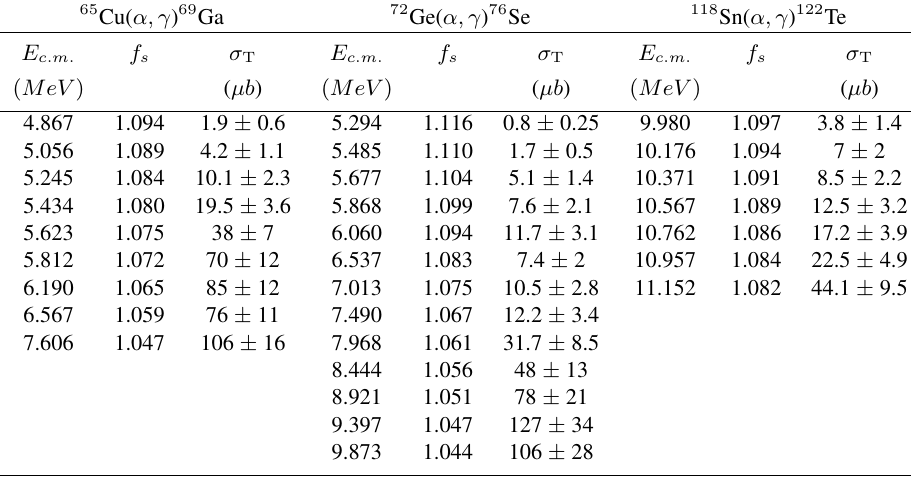
Table 2. Screening corrected total cross sections ( σ T ) measured for 65 Cu( α, γ ) 69 Ga, 72 Ge( α, γ ) 76 Se and 118 Sn( α, γ ) 122 Te at center-of-mass energies E c.m. . f s are the screening correction factors.